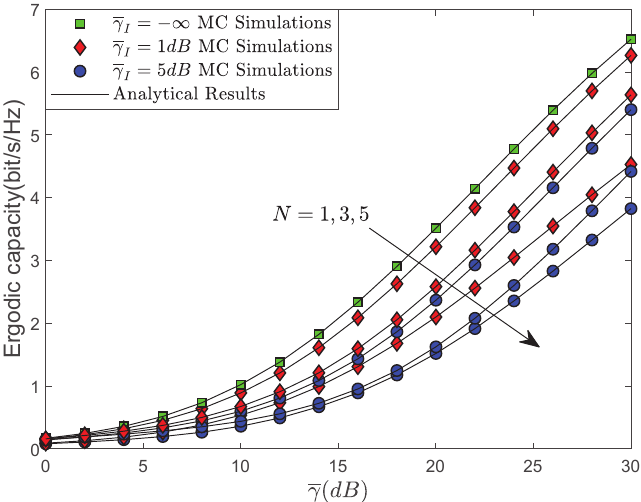
Figure 5. EC versus ¯ γ for different CCI situation.